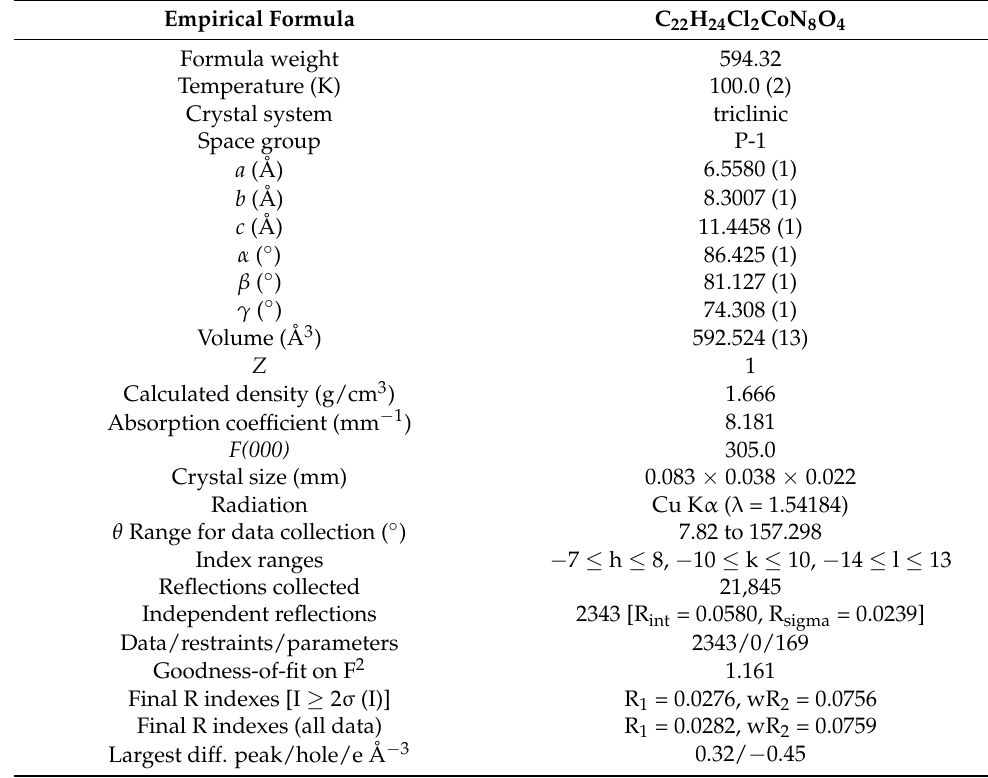
Table 5. X-ray diffraction data, and structure-refinement details, for C1